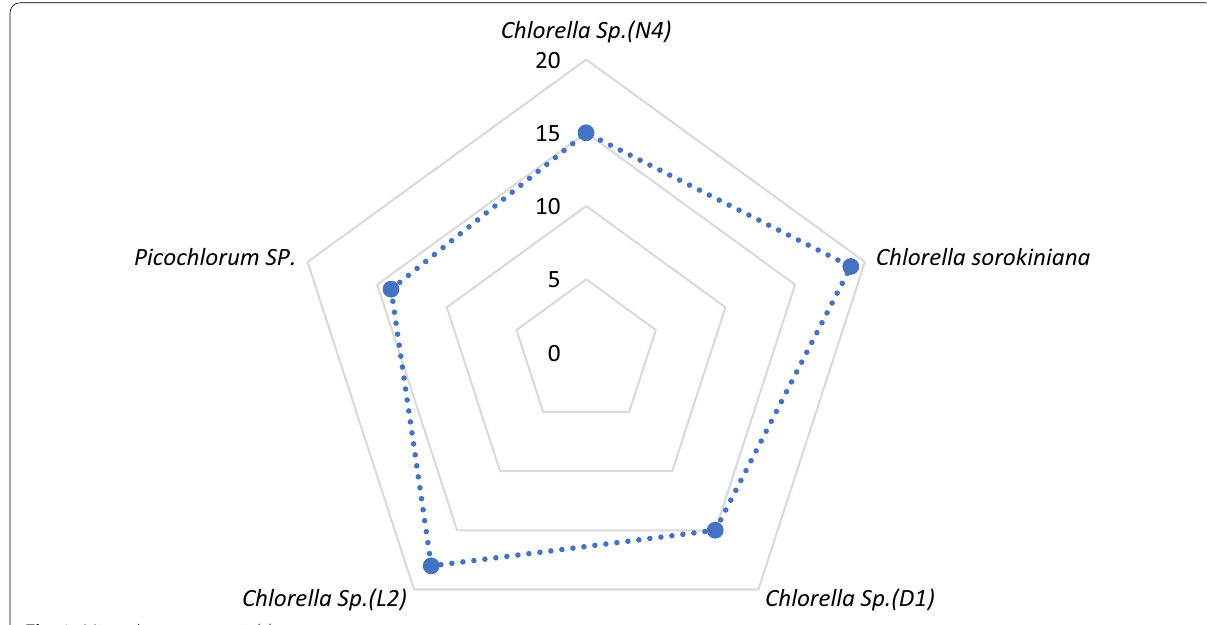
Fig. 2 Microalgae extract yield